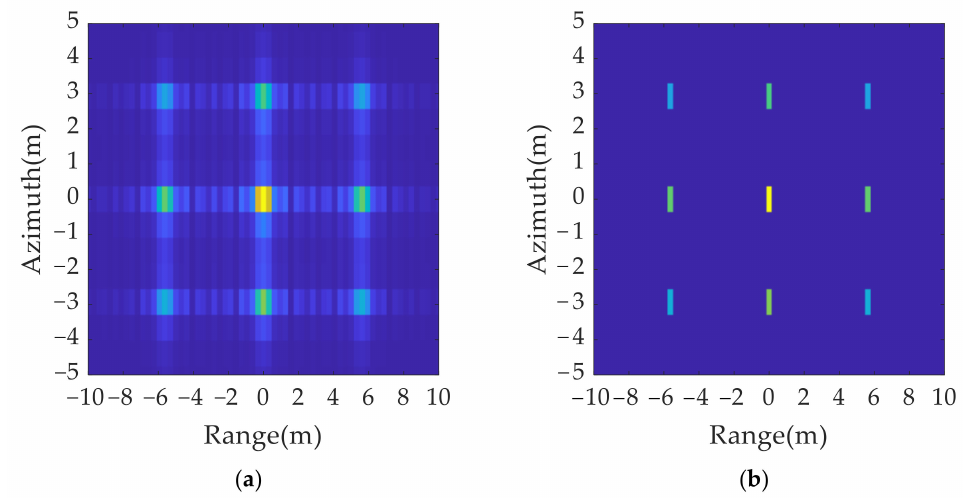
Figure 9. 2D deception jamming results: ( a ) jamming results without eliminating sidelobe; ( b ) jam- ming results after eliminating sidelobe.